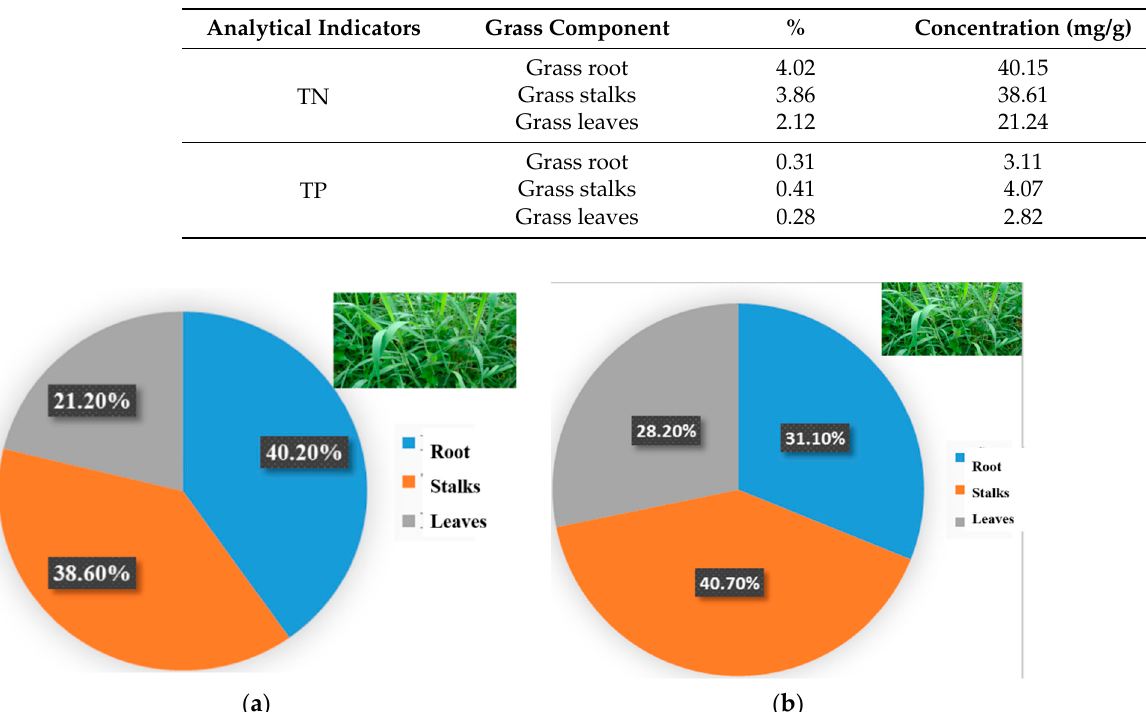
Table 2. Accumulated concentrations of N, P in Para grass.